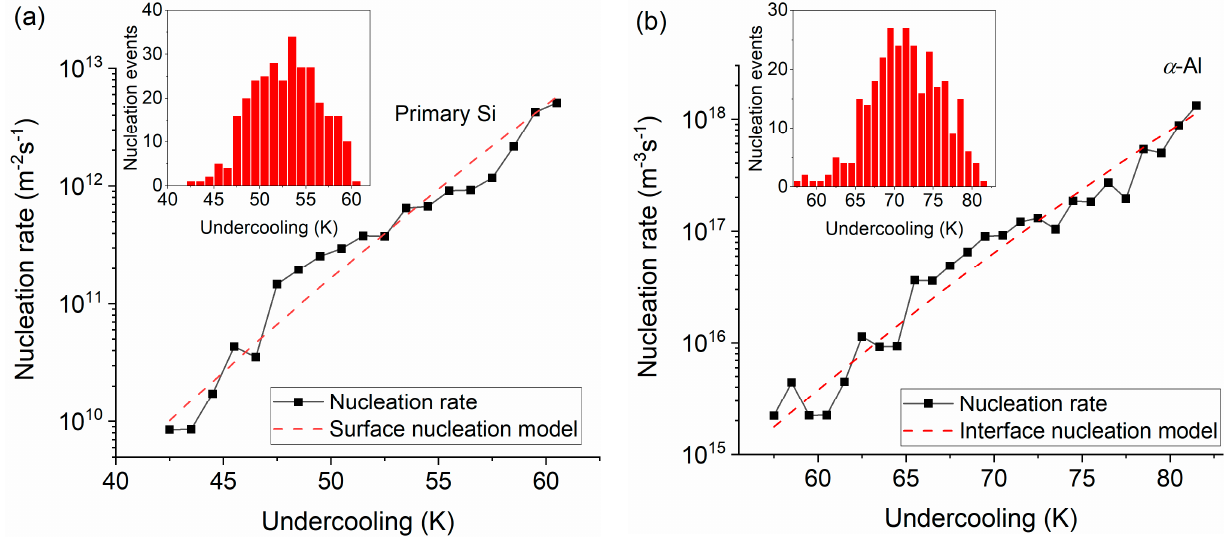
Figure 5. Nucleation rates as a function of undercooling for the ( a ) primary Si and ( b ) α -Al dendrites. The dashed curves indicate the best fit to the data for the surface and interface heterogeneous nucleation models. Distributions of nucleation events versus undercooling are shown in the insets.